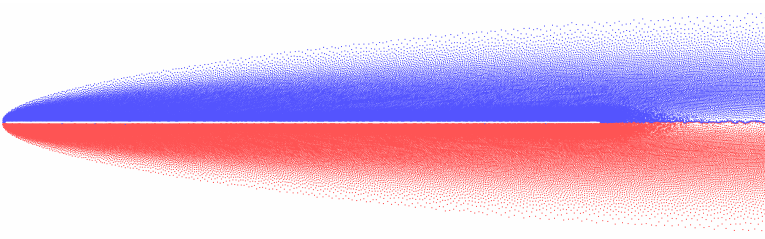
Figure 3. Vortex particles positions in steady-state regime for the Blasius flow.